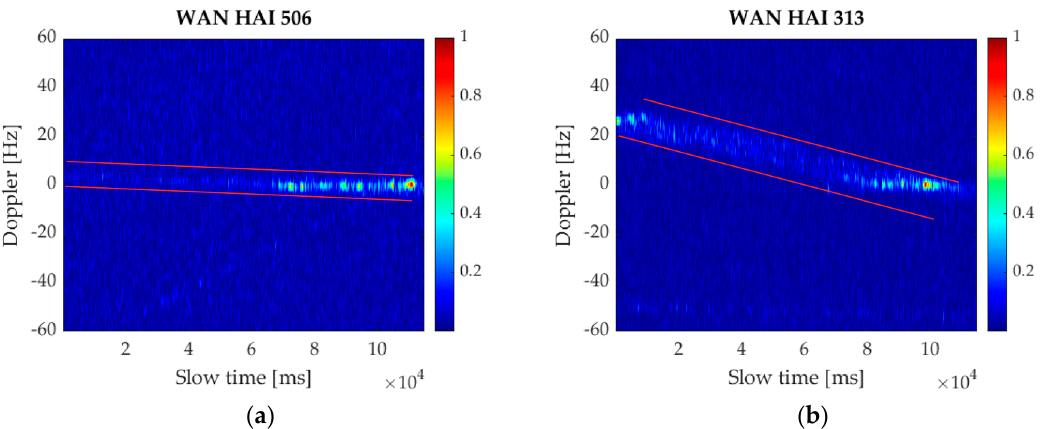
Figure 8. Two time-frequency distributions for two cargo ships in the field test: ( a ) is WAN HAI 506 with a speed = 4.94 m/s, GPS PRN3 satellite elevation angle = 40°, and azimuth angle = 68°; ( b ) is WAN HAI 313 with a speed = 7.21 m/s, GPS PRN22 satellite elevation angle = 19°, and azimuth angle = 46°.